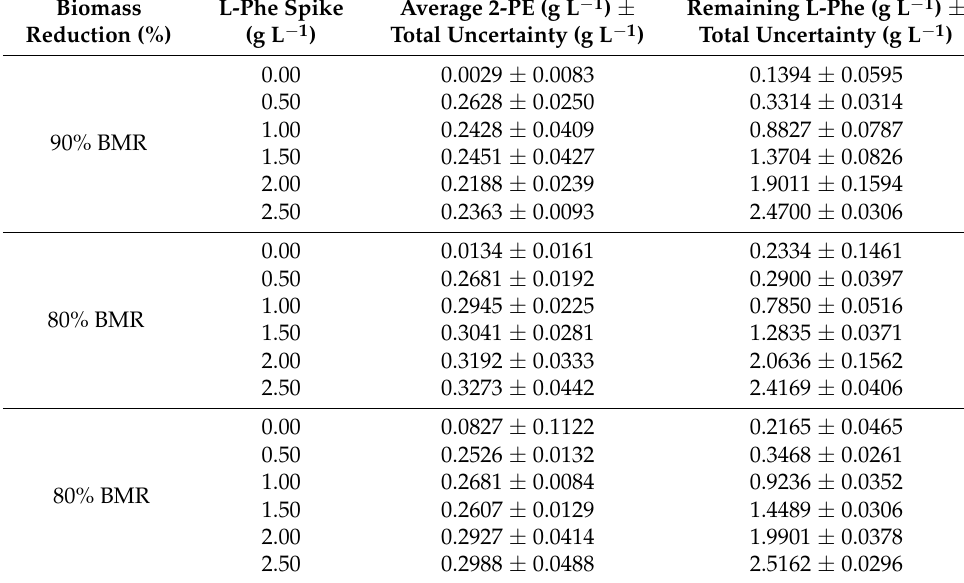
Table 1. Average concentrations of 2-PE and L-PHE for the biomass reduction and L-phe treatment combinations after fermentation. Total uncertainty was calculated from RMSD and standard deviation of the triplicate experimental